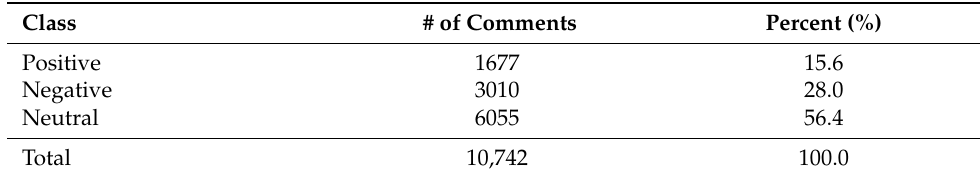
Table 3. Number of users’ comments among sentiment